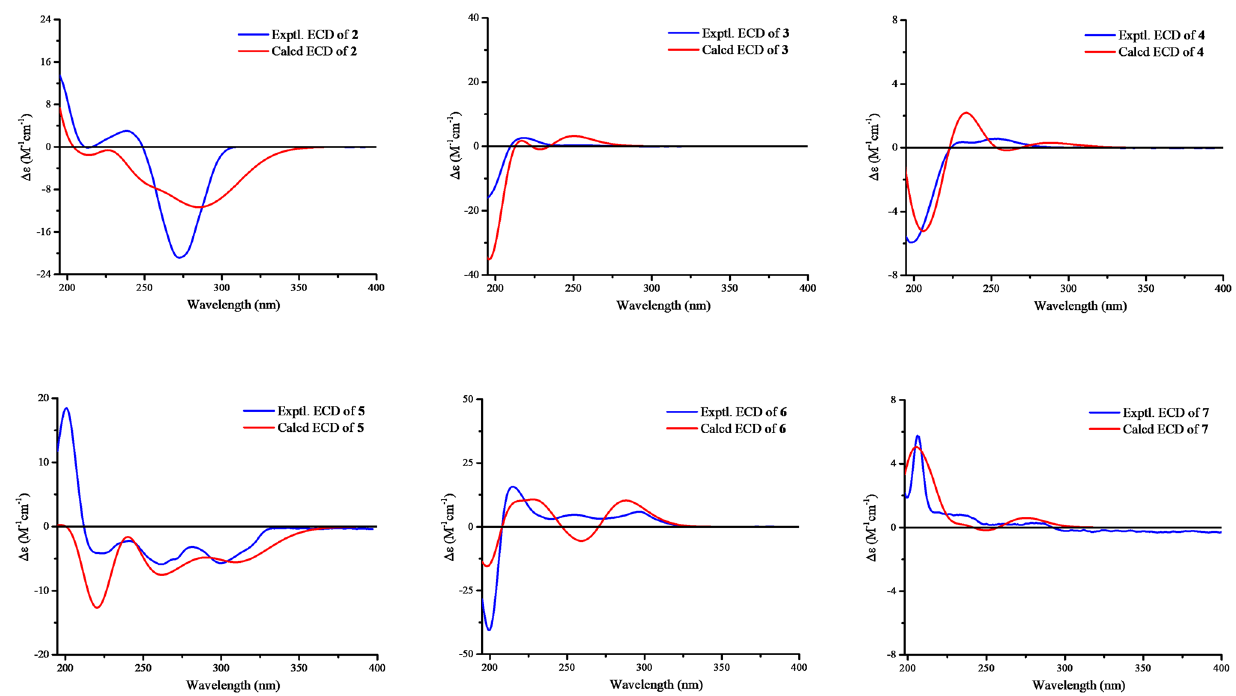
Fig. 5 The experimental and calculated ECD spectra of compounds 2 – 1 3